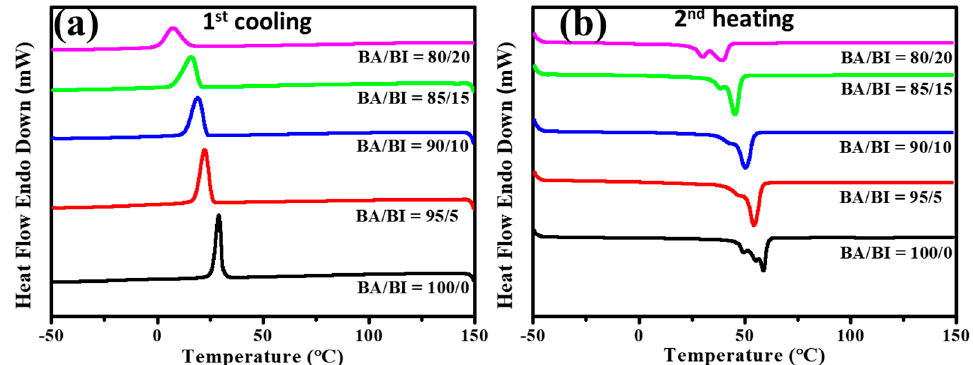
Figure 3. DSC trace of PBABI copolyesters: ( a ) cooling curves in the first cycle and ( b ) reheating curves in the second cycle. Table 2. Thermal properties of PBABI copolyesters.